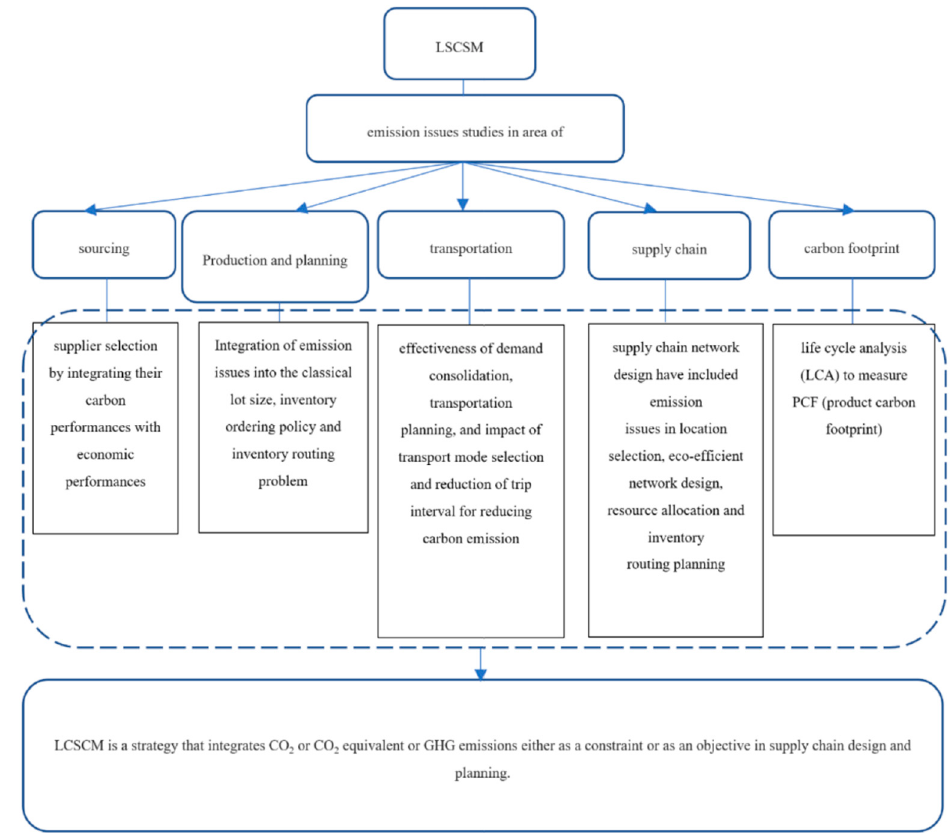
Figure 3. LCSCM framework. Source: own elaboration on the basis of [25].